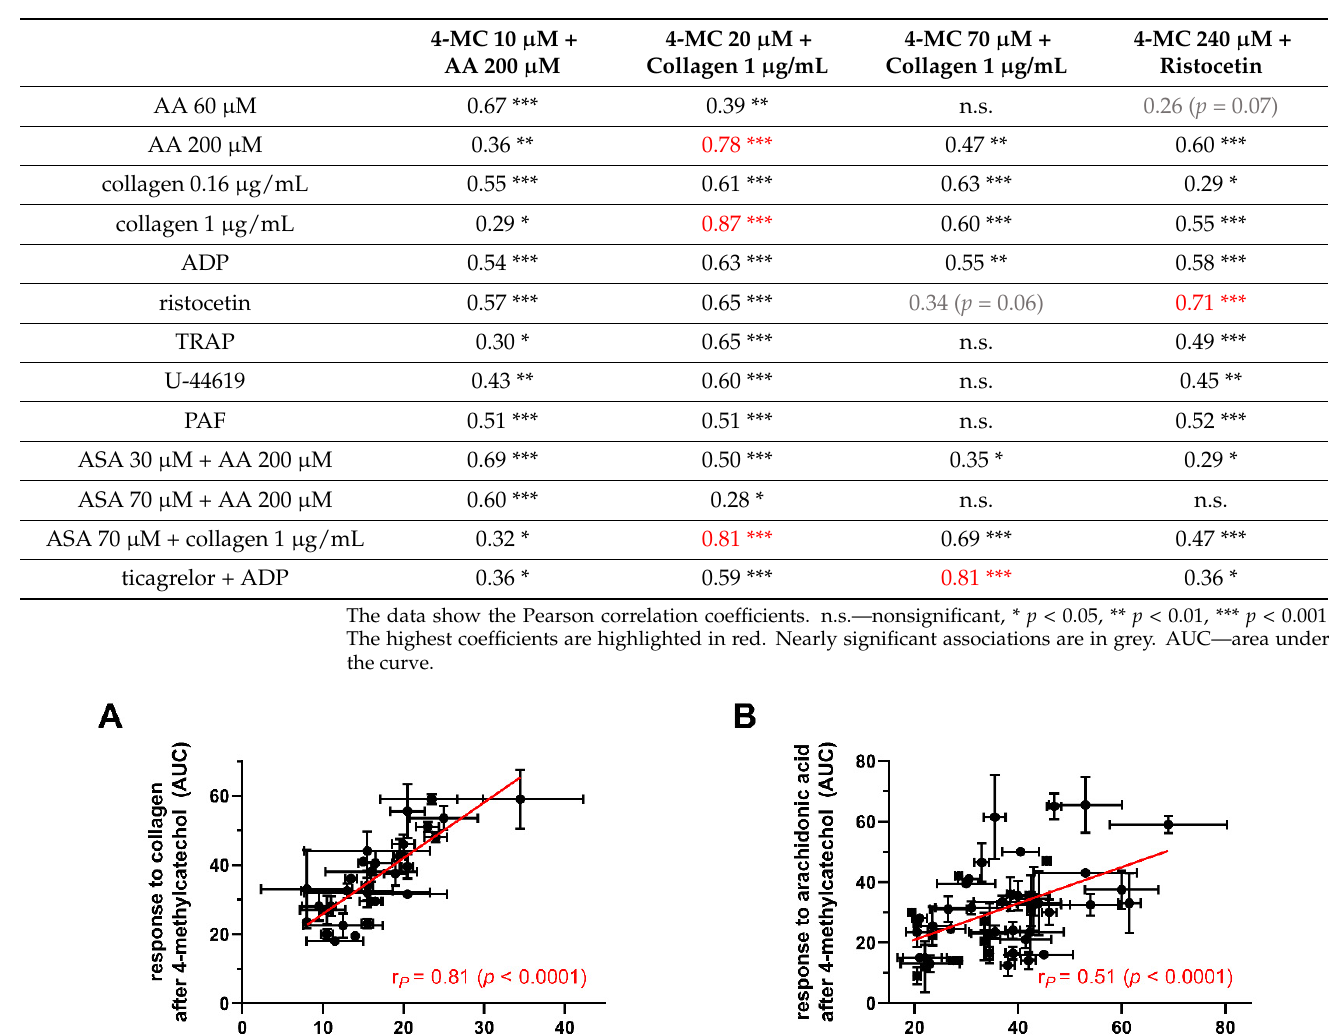
Table 2. Relationships between the responses to 4-methylcatechol and other aggregation responses (expressed as AUC).